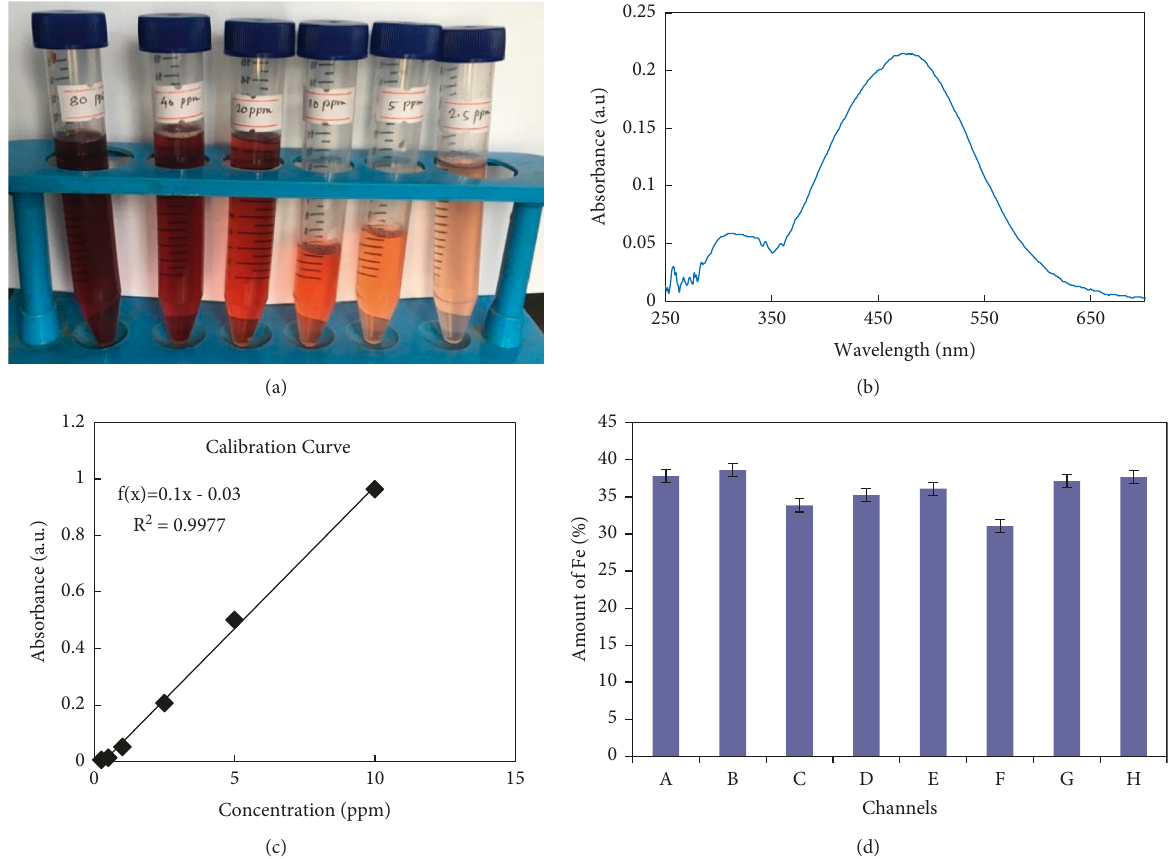
max of the ferric thiocyanate complex